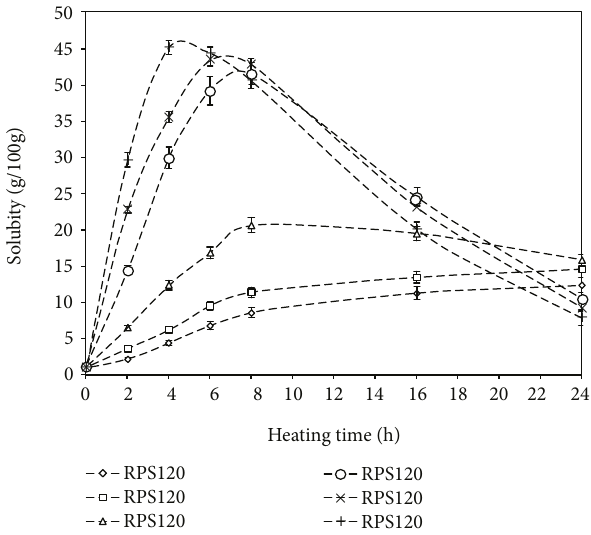
Figure 1: In fl uence of time-temperature roasting conditions on the solubility of potato starch (PS). Note here that in these subsequent plots, error bars are not included whether the uncertainty in data magnitudes is smaller than the symbol